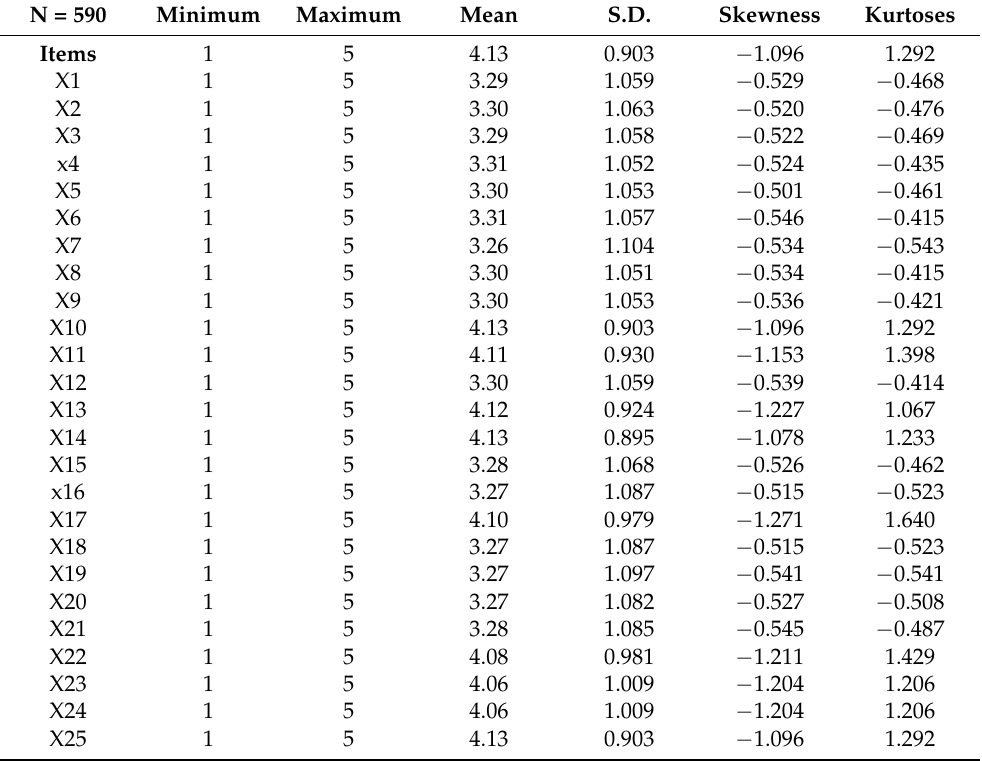
Table 4. Descriptive